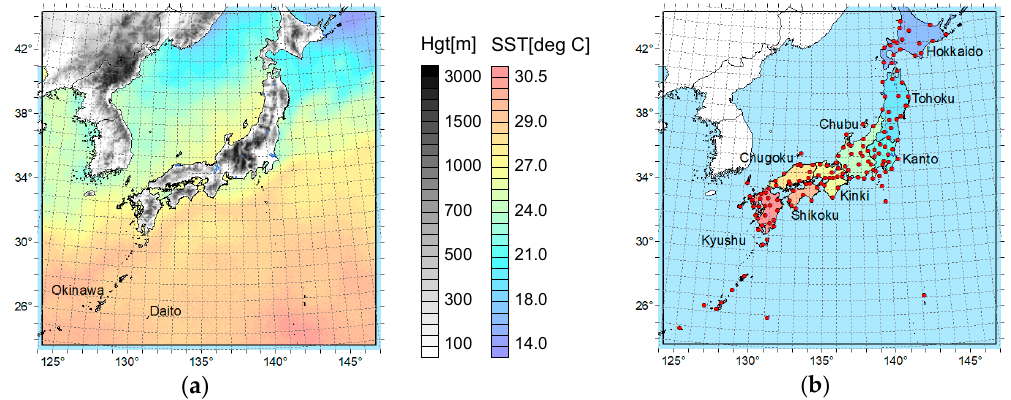
Figure 1. Modeling domains showing ( a ) topography of land areas and average SST (sea surface temperature) of August 2014; ( b ) locations of meteorological observatories and division of regions for analyses of precipitation.